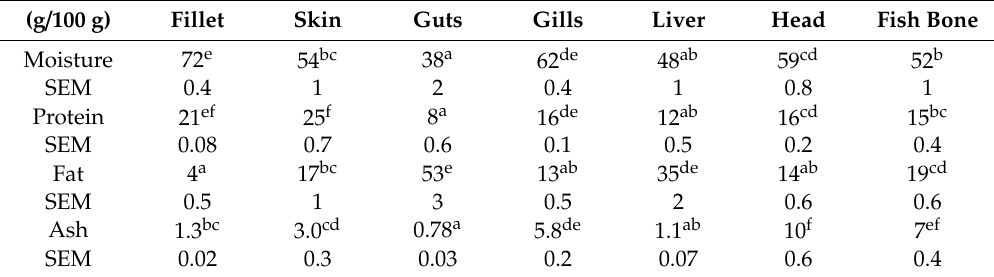
Table 1. Chemical composition of sea bass fillet and